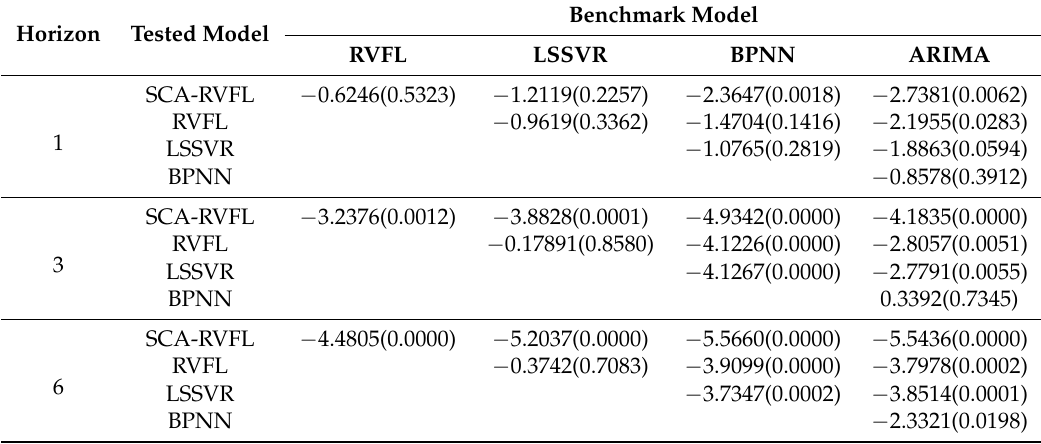
Table 3. Results of Diebold-Mariano (DM) test of single models.